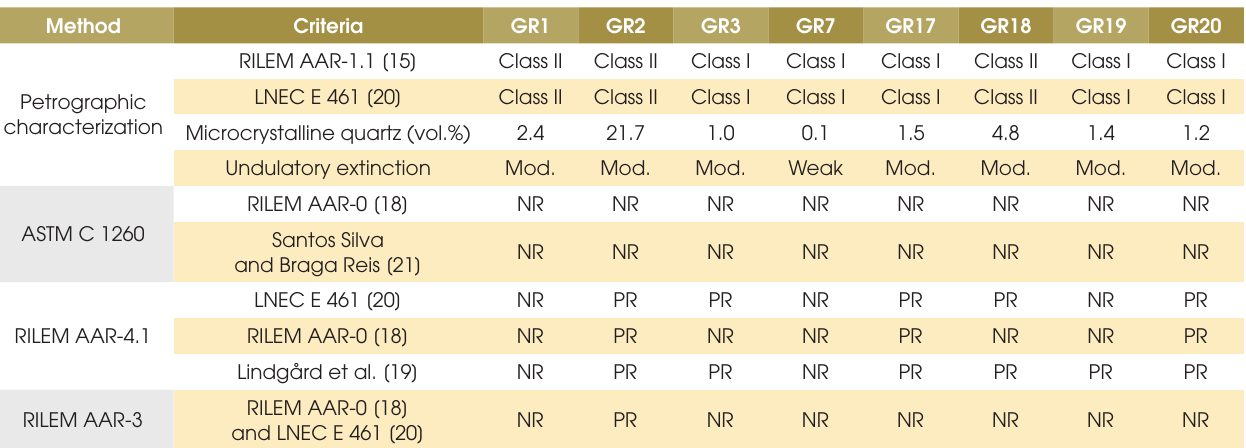
Table 3 – Summary of the results achieved in the different methodologies used for the assessment of the potential reactivity of the granitic